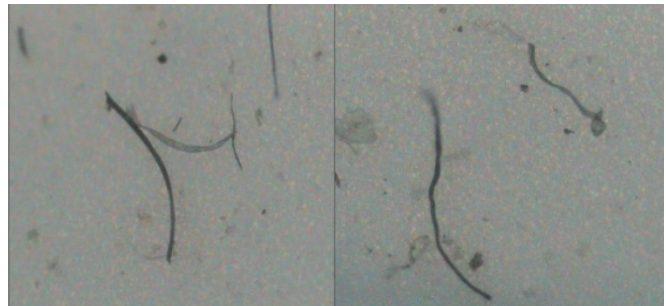
Figure 8. Fibers released from woven fabrics.